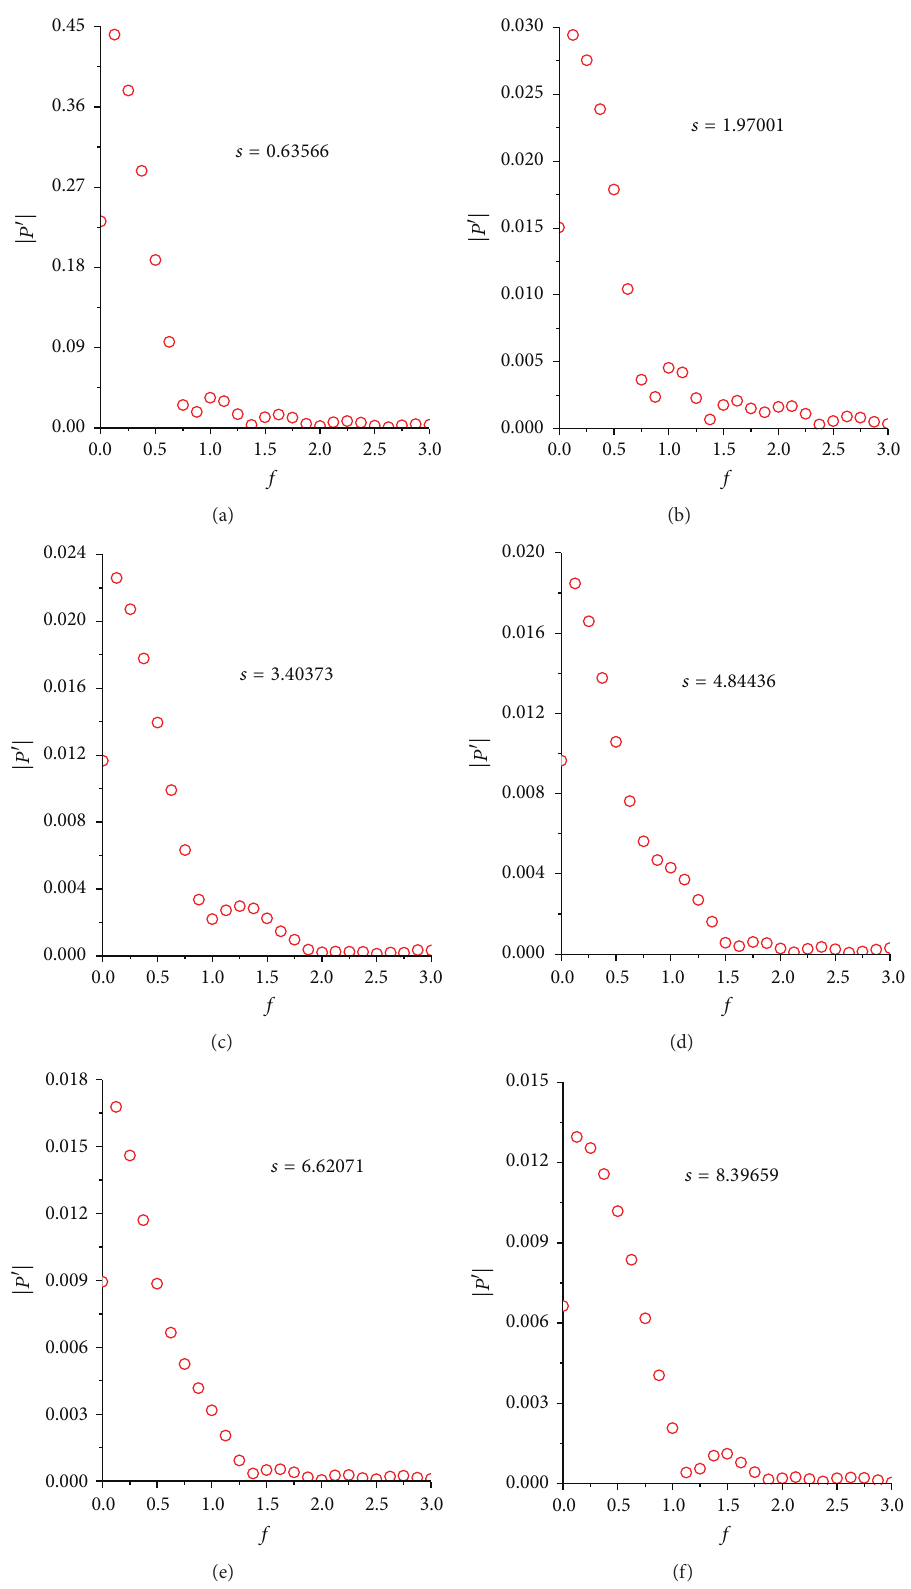
Figure 7: Frequency spectrum analysis of pressure disturbance at different locations in the response